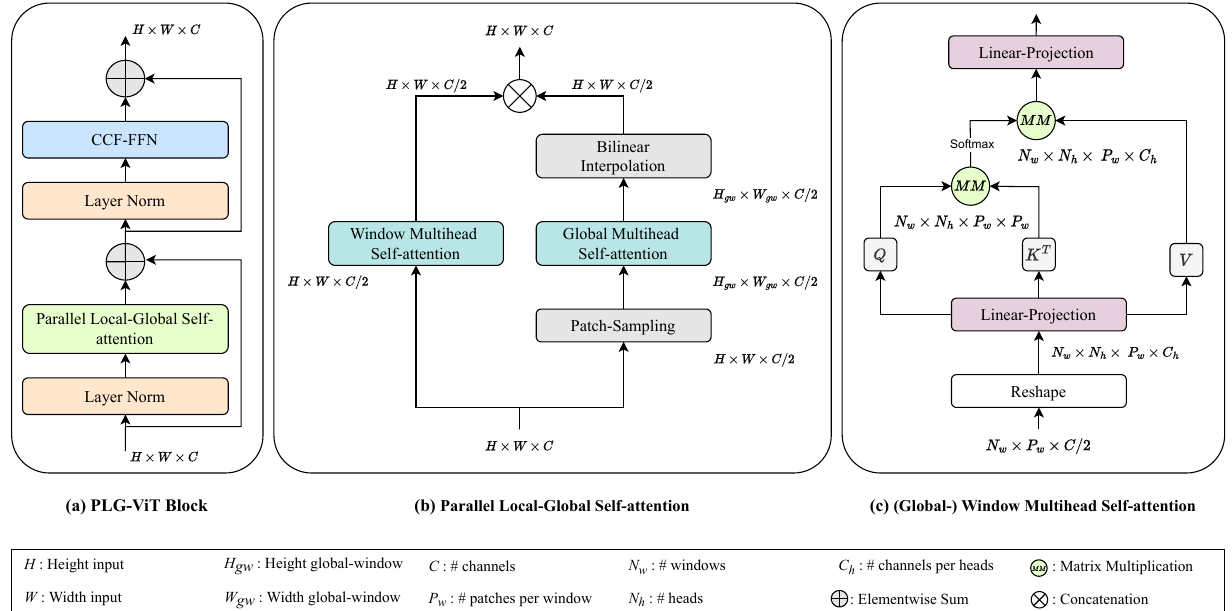
Figure 3. Model architecture of our PLG-SA block. The PLG-ViT block consists of the parallel local-global self-attention and the convolutional feed-forward network (CCF-FFN). The parallelism of window self-attention and global self-attention enables efficient as well as effective recognition of fine-grained local in addition to coarse-grained global features and interactions in the